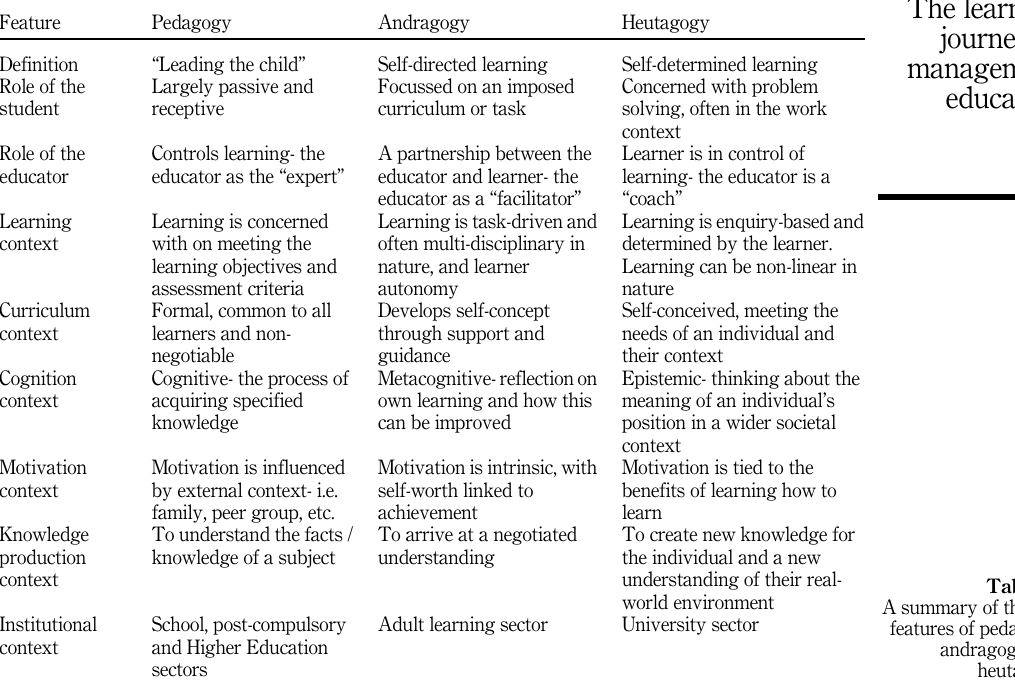
Table 1. A summary of the key features of pedagogy, andragogy and